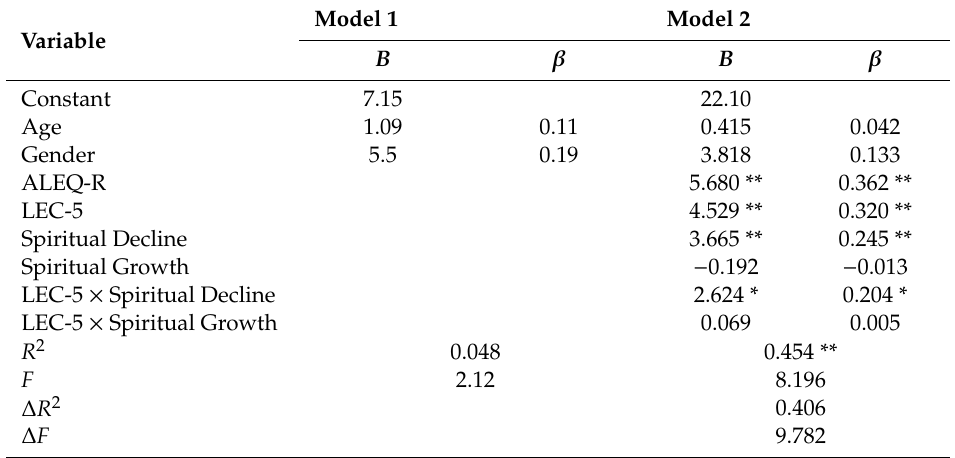
Table 4. Hierarchical Regression Predicting PTS from PTEs and Adolescent Negative Life